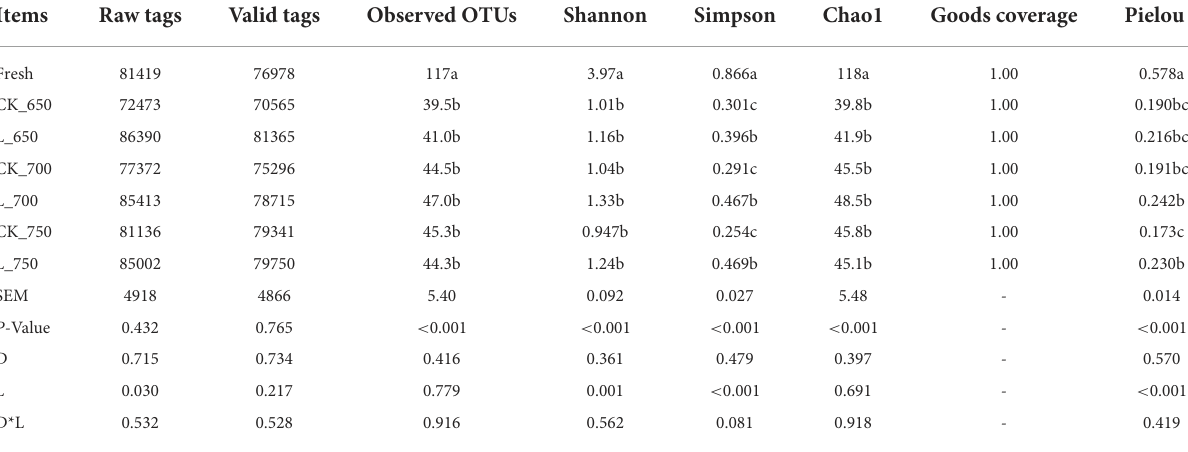
TABLE 5 Sequencing data and alpha diversity of bacteria in sweet sorghum silages ( n = 4). Items Raw tags Valid tags Observed OTUs Shannon Goods